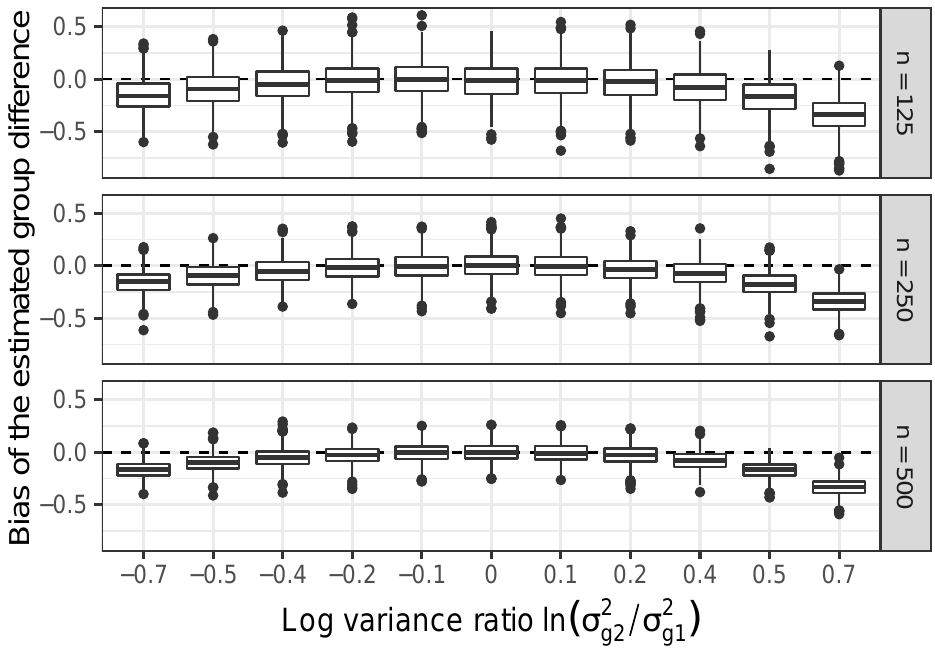
Figure 6. Boxplots with the bias of the estimated group difference in the error variance σ 2